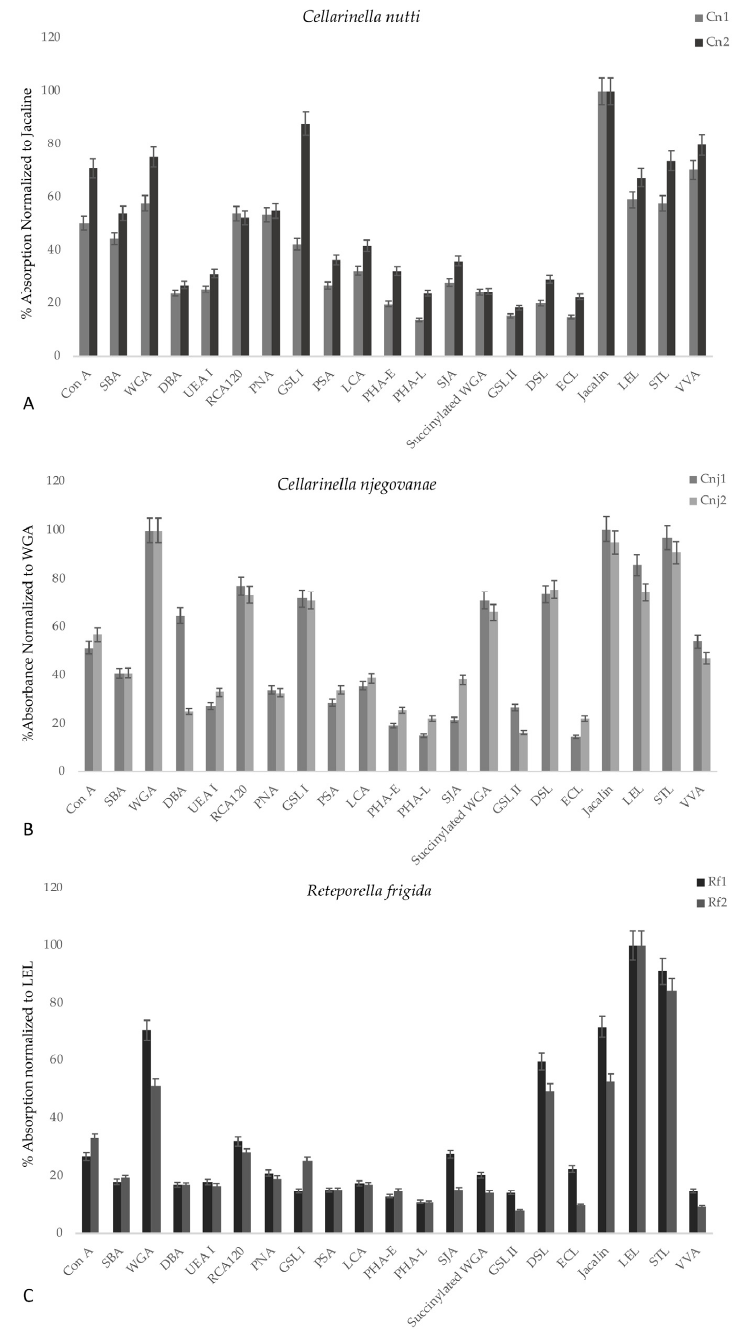
Figure 10. Enzyme-linked lectin assay (ELLA) on the three extracted ASMs. ELLA was performed with 21 lectins tested on: ( A ) Cellarinella nutti , ( B ) Cellarinella njegovanae and ( C ) Reteporella frigida . One and two are replicates. Absorbance values at 405 nm were normalized to the highest values (Jacalin, WGA and LEL), corresponding to 100% reactivity (n = 4, mean ± S.E.), for C. nutti ( A ), C. njegovanae ( B ) and R. frigida ( C ), respectively.